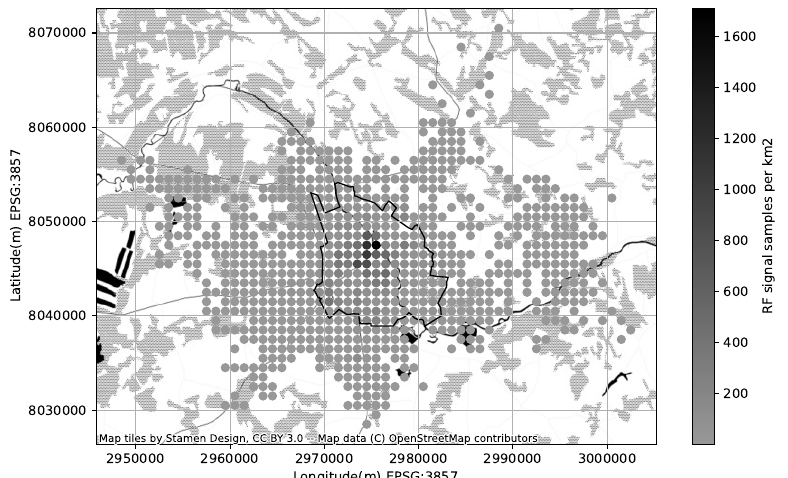
Figure 8. Confidence of the crowd-collected RF signal samples (cellmapper.net (accessed on 11 January 2023)), the circles on the map represent the amount of RF signal samples collected per square kilometer, and the polygon represents the boundaries of Tartu city.